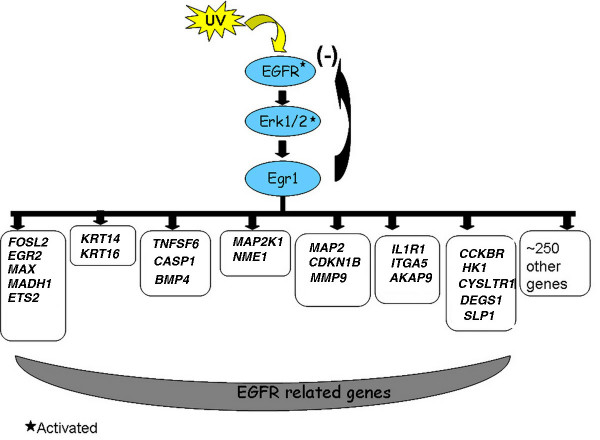
Schematic diagram of the activation of Egr1 and the identification of its downstream targets upon UV simulation.